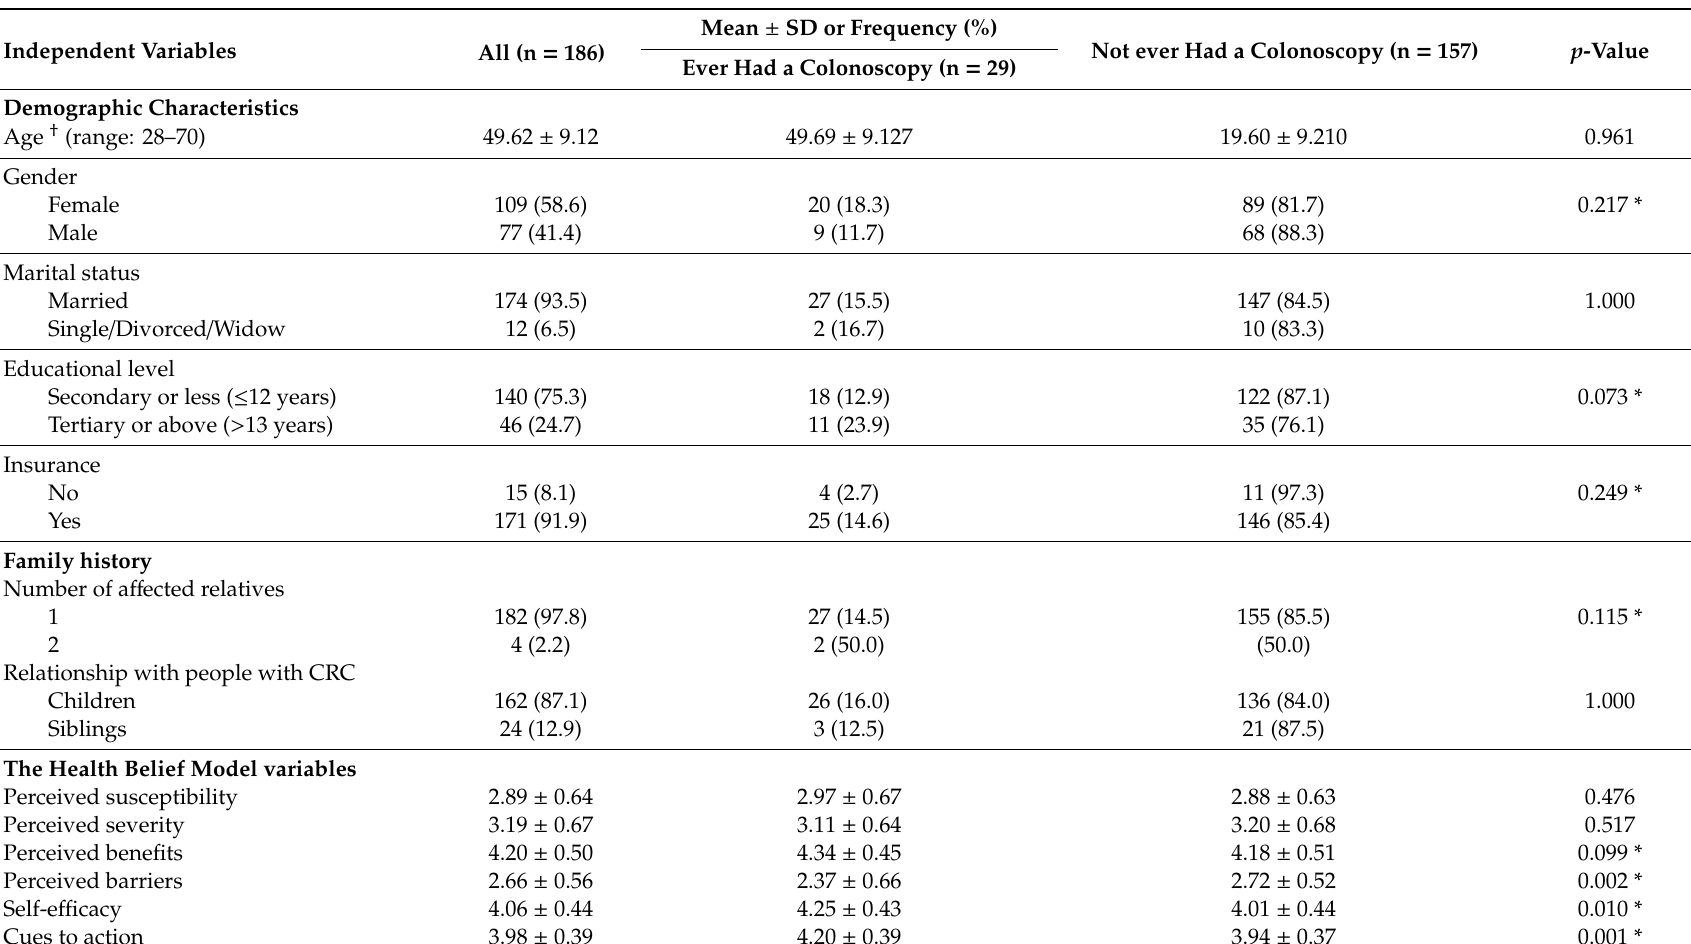
Table 1. Social demographic, family history and the health belief model variables and their relationship with undergoing colonoscopy (n = 186). Mean ± SD or Frequency (%) Independent Variables All (n = 186) Not ever Had a Colonoscopy (n = 157) p -Value Ever Had a Colonoscopy (n = 29) Demographic